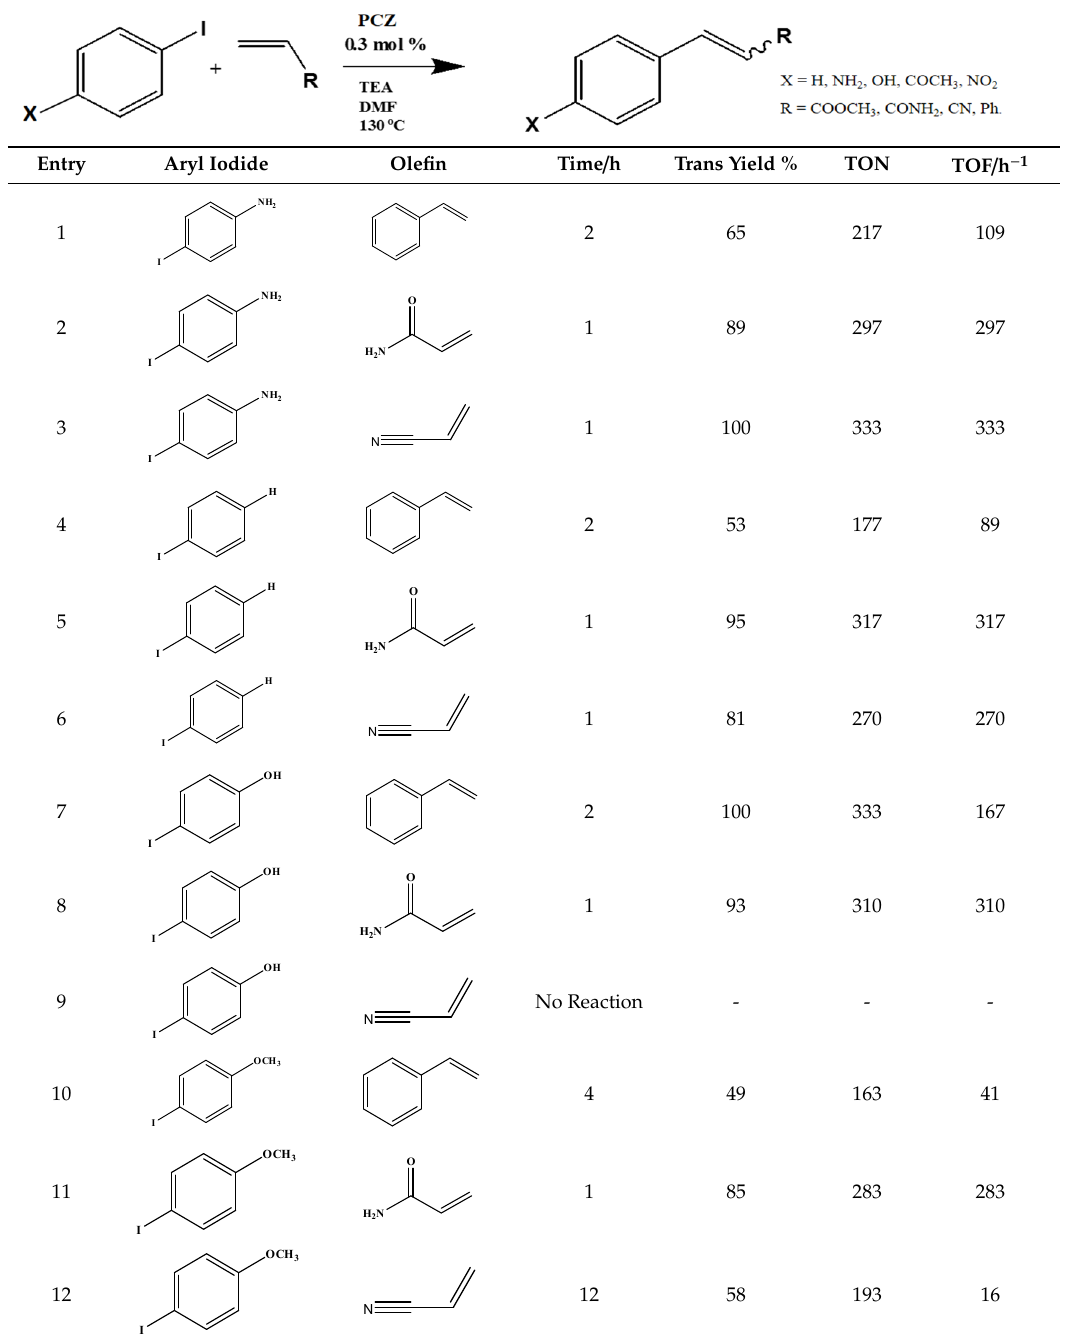
Table 9. Reactions between coupling Table 9. Reactions between coupling pairs. Table 9. Reactions between coupling pairs. Table 9. Reactions between coupling pairs. Table 9. Reactions between coupling pairs. Table 9. Reactions between coupling pairs. Table 9. Reactions between coupling pairs. Table 9. Reactions between coupling pairs. Table 9. Reactions between coupling pairs. Table 9. Reactions between coupling pairs. Table 9. Reactions between coupling pairs. Table 9. Reactions between coupling pairs. Table 9. Reactions between coupling pairs. Table 9. Reactions between coupling pairs. Table 9. Reactions between coupling pairs. Table 9. Reactions between coupling pairs. Table 9. Reactions between coupling pairs. Table 9. Reactions between coupling pairs. Table 9. Reactions between coupling pairs. Table 9. Reactions between coupling pairs. Table 9. Reactions between coupling pairs. Table 9. Reactions between coupling pairs. Table 9. Reactions between coupling pairs. Table 9. Reactions between coupling pairs.